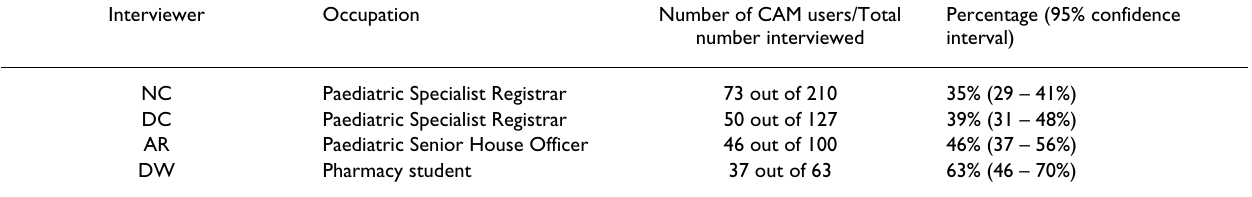
Table 4: CAM use disclosure by interviewer